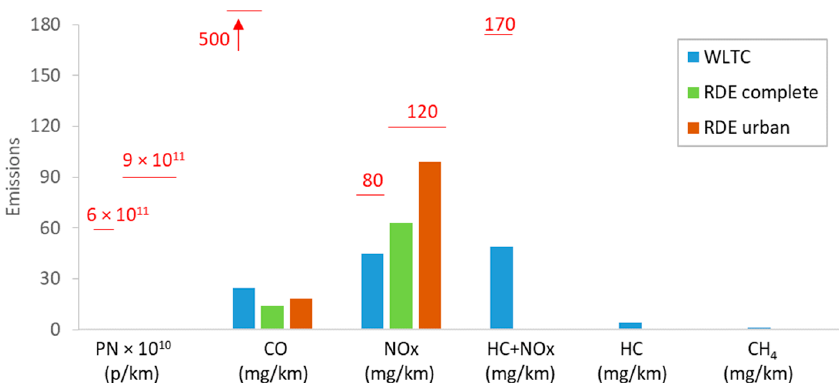
Figure A1. Regulated pollutants emissions for the laboratory worldwide harmonized light-duty vehicles test cycle (WLTC) and the on-road real-driving emissions (RDE) tests. Red lines give the limits in the laboratory and on the